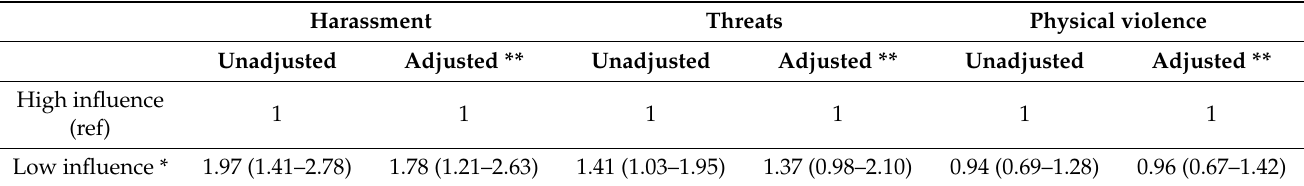
Table 4. Associations between influence over own work situation and harassment, threats and violence.